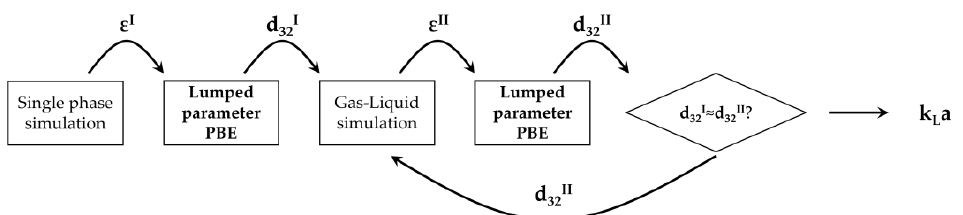
Figure 2. Schematic diagram of the PBM-based iterative procedure for the bubble size determination and gas – liquid